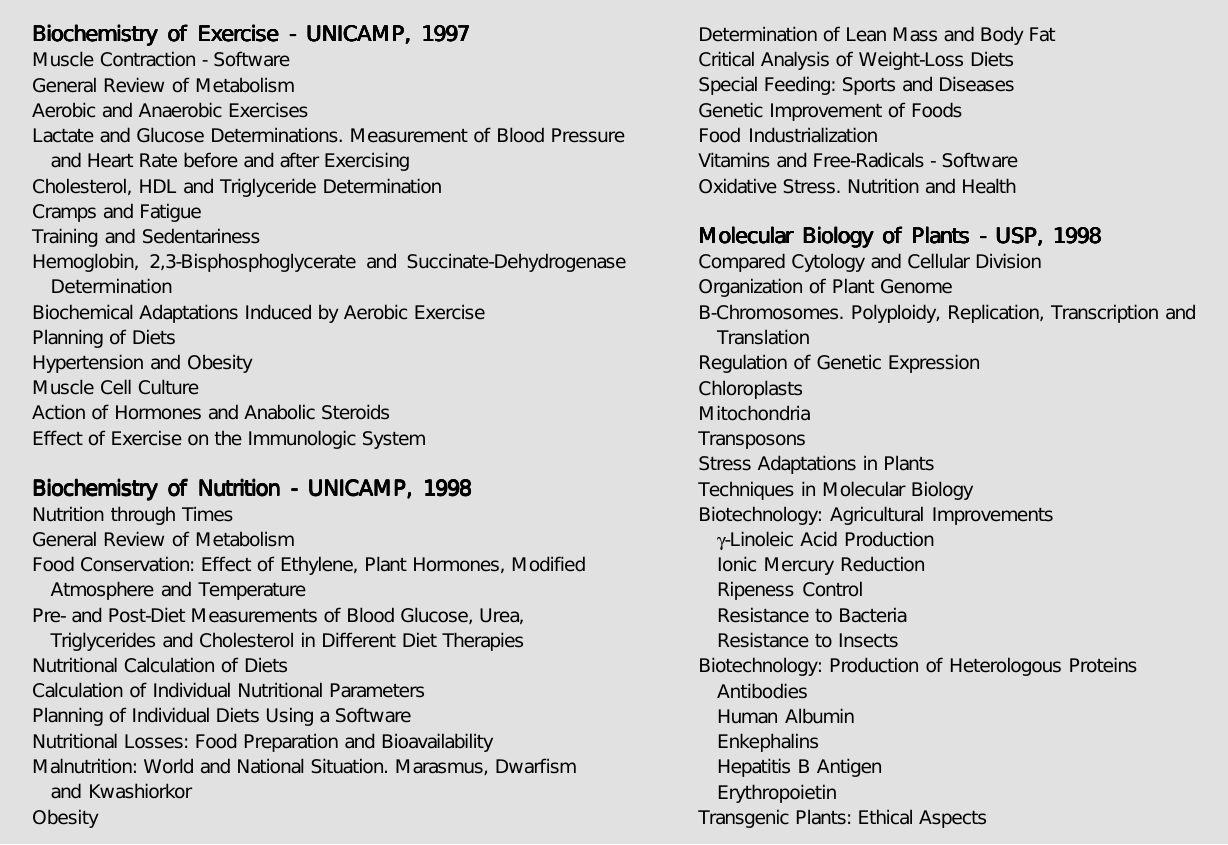
Table 1 - Programs of the undergraduate optional courses